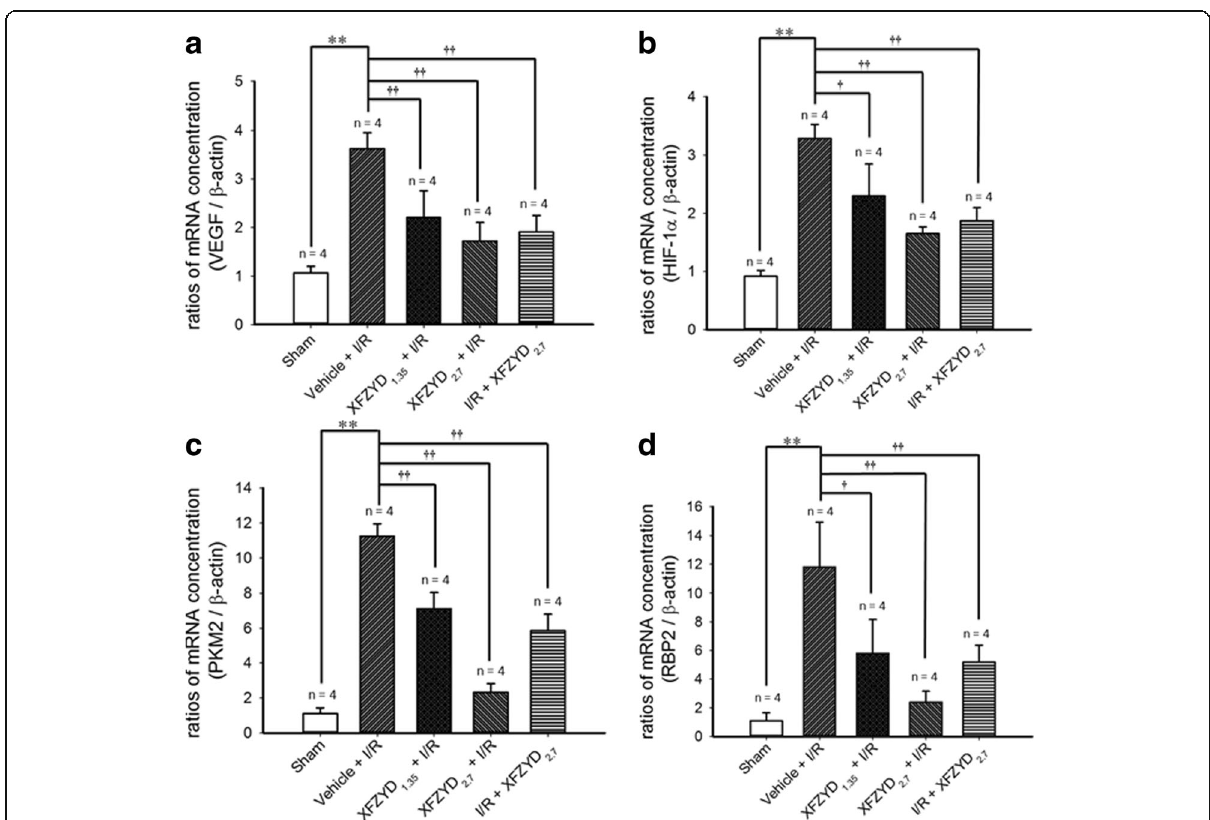
Fig. 7 The ratios of the mRNA concentrations of VEGF, HIF-1 α , PKM2 and RBP2 relative to that of β -actin. Total mRNA was extracted from the sham retinas or the ischemic retinas pretreated with vehicle, a low dose XFZYD (1.35 g/Kg/day), a high dose XFZYD (2.7 g/kg/day), or posttreated with a high dose XFZUD. The mRNA concentration ratios of VEGF ( a ), HIF-1 α ( b ), PKM2 ( c ) and RBP2 ( d ) relative to β -actin were calculated. The mean values ± SD ( n = 4) was shown for each bar. ** ( p < 0.01) represents significance (Sham vs. Vehicle + I/R). † ( p < 0.05) or †† ( p < 0.01) represents significance (Vehicle + I/R vs. XFZYD 1.35 + I/R, XFZYD 2.7 + I/R, or I/R + XFZYD 2.7 ). VEGF: vascular endothelial growth factor, HIF-1 α : hypoxia inducible factor 1 α , PKM2: pyruvate kinase M2, RBP2: retinoblastoma-binding protein